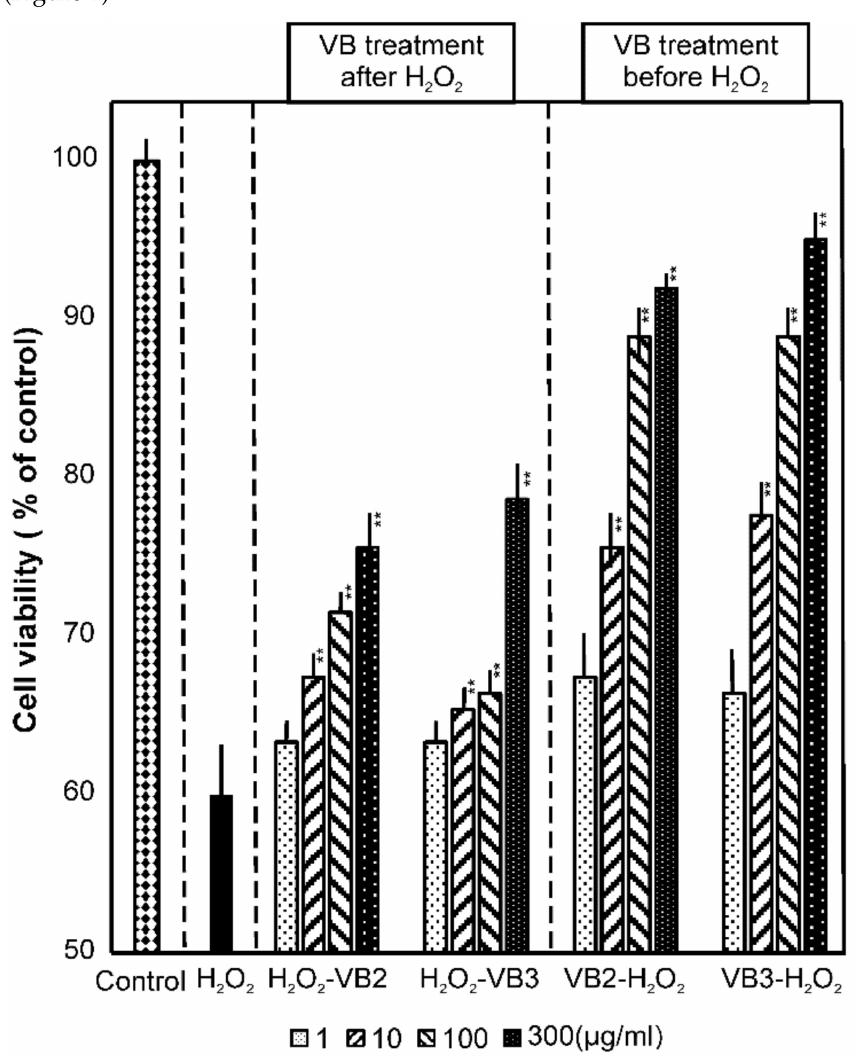
Figure 4. Protective effects of VB2 and VB3 on the viability of NHDF treated with H 2 O 2 . NHDF were treated with VBs in the presence of H 2 O 2 as described in the Materials and Methods. Cells were cultured for another 18 h and viability was measured. The significance of differences in the effects of VBs on cell viability was analyzed in comparison with that in the H 2 O 2 -treated group. ** p <